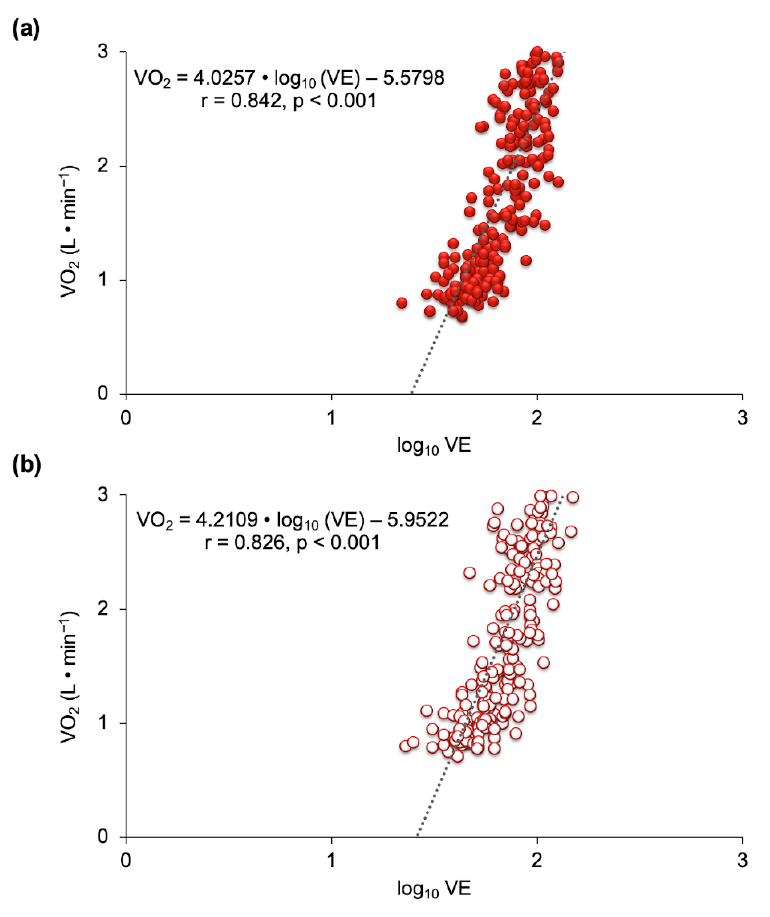
Figure 5. Relationship between oxygen uptake (VO 2 ) log 10 ventilation (VE) (OUES) after beetroot juice ( a ) and a placebo ( b ) ( n = 11).